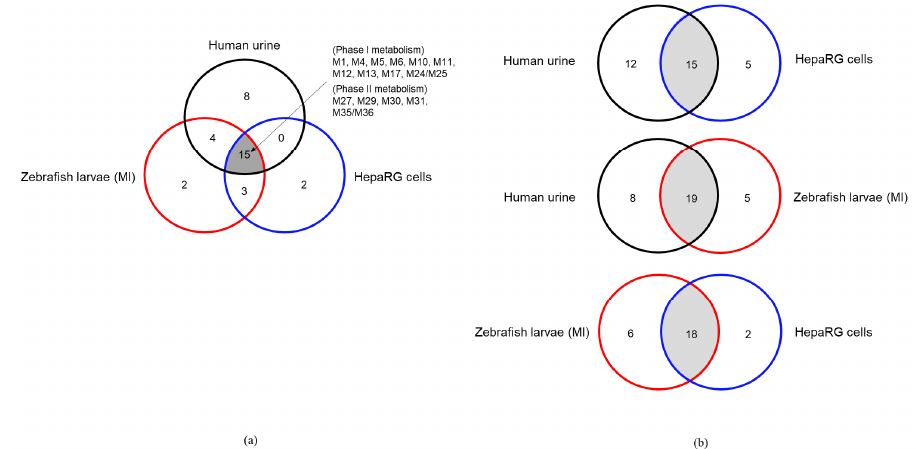
Figure 3. Comparison of the metabolites observed from the three models [human urine samples, zebrafish larvae (exposed via microinjection; MI), and HepaRG cells] using Venn diagrams. ( a ) Common metabolites detected among all models and ( b ) their mutual comparability. Table 2. Comparison of the major metabolites detected in the investigated models using LC-HRMS /